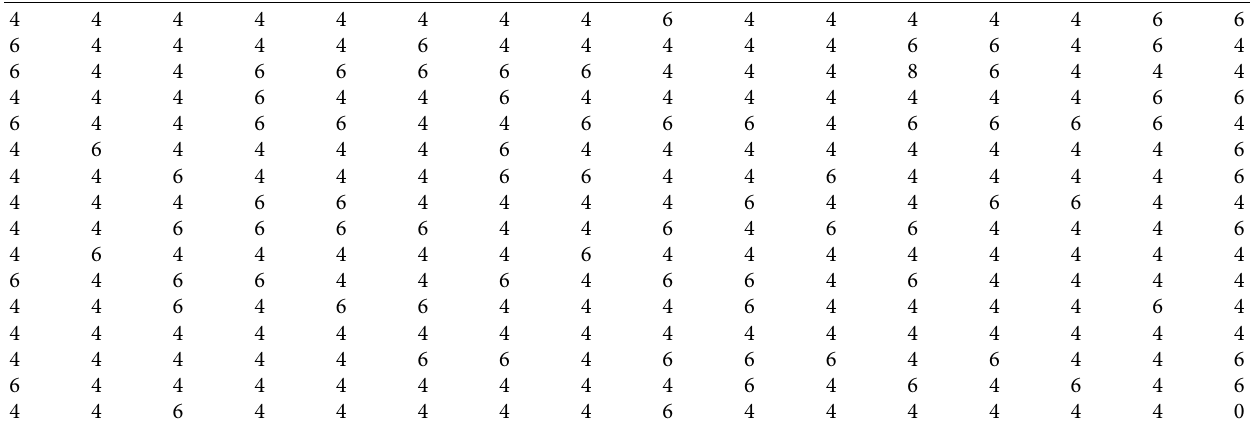
Table 6: Differential distribution table for proposed S-box.